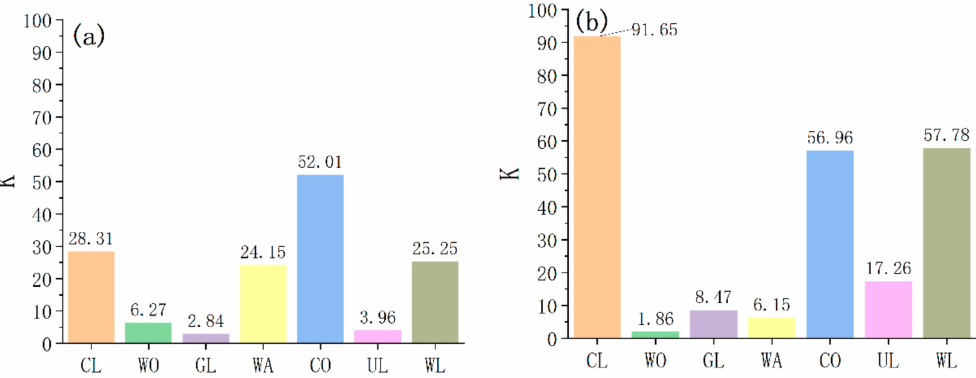
Figure 4. Dynamic degrees of LULC in RES ( a ) and ESA ( b ).